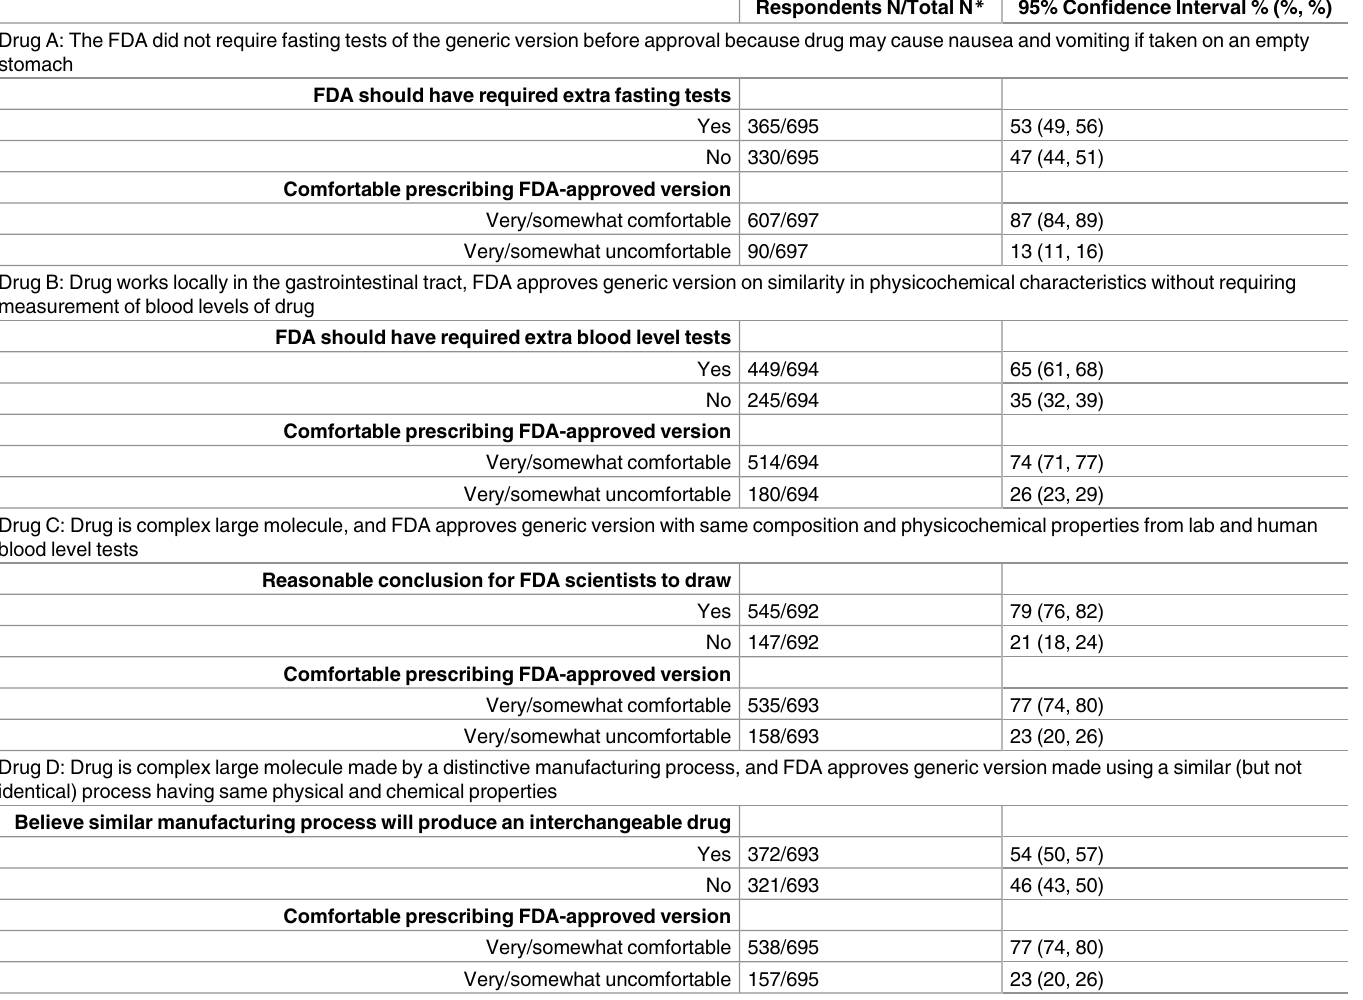
Table 3. Physicians’ perceptions of hypothetical scenarios of product-specific FDA approval processes for generic